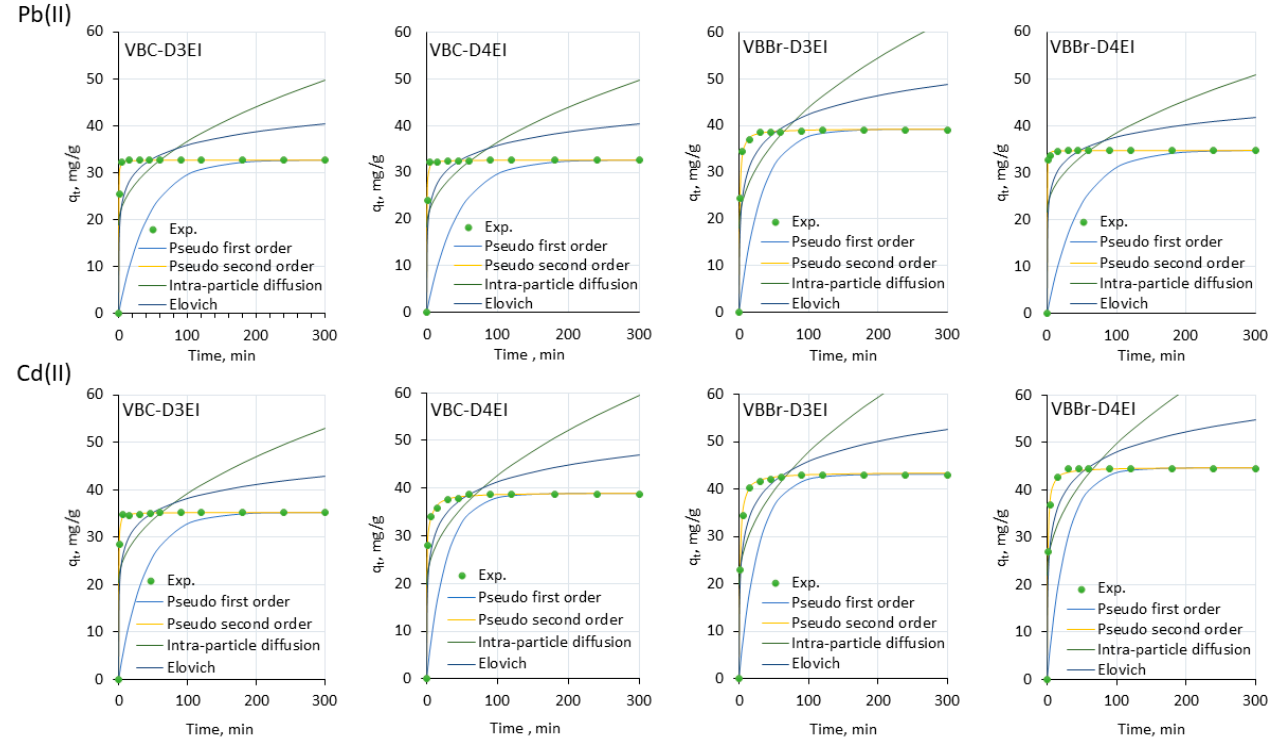
Figure 7. Experimental data of adsorption kinetic and non-linear fitting of kinetic models for adsorption of Pb(II) and Cd(II) onto resin surfaces (metal ion concentration, 50 mg/L; sorbent dosage, 0.1 g; V, 100 mL, pH 5).